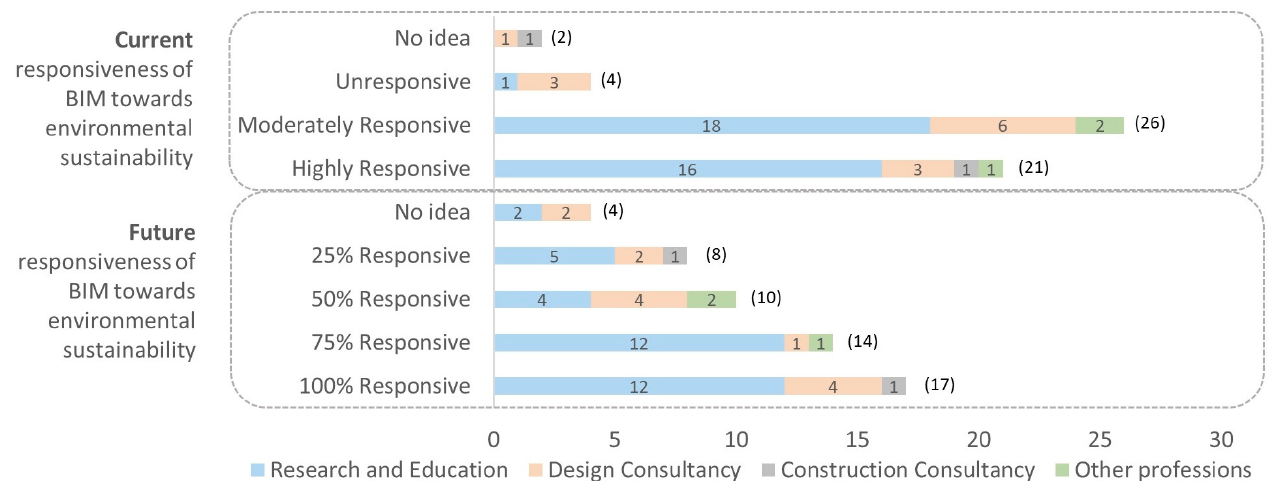
Figure 9. Current and future responsiveness of BIM towards environmental sustainability.